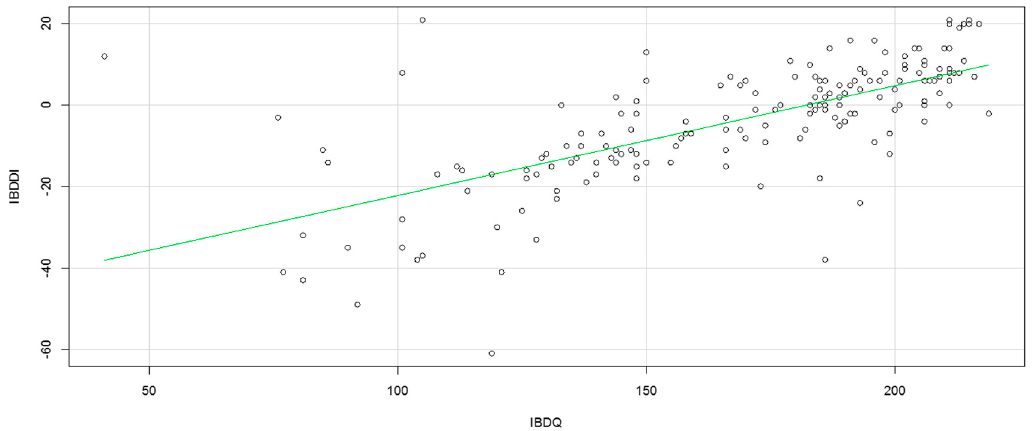
Figure 1. Concurrent validity, Inflammatory Bowel Disease Disability Index, and Inflammatory Bowel Disease Questionnaire-32 correlation.